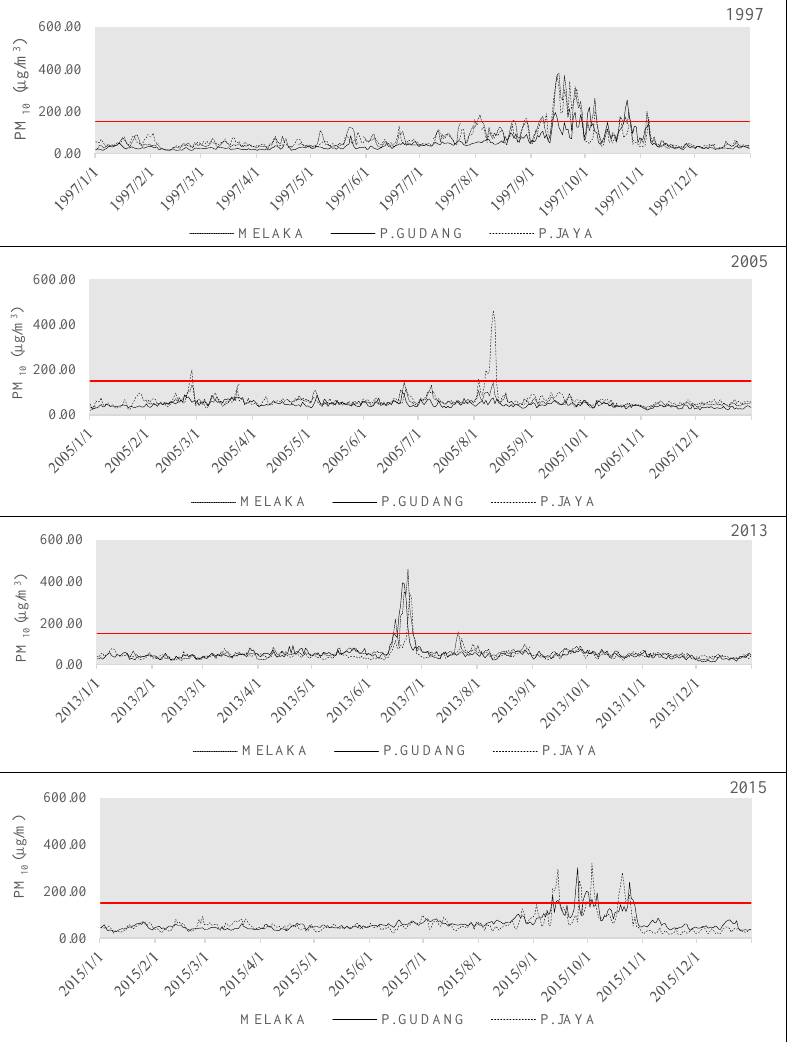
Figure 4. Daily time series plot of PM10 level in Petaling Jaya, Melaka, and Pasir Gudang in 1997, 2005, 2013, and 2015. Figure 5 shows the backward trajectories of air parcels during the haze events in 2005, 2013, and 2015 at the studied areas. The trajectories were calculated for 48 h periods at a height of 500 m above ground level (AGL). Figure 5a indicates that during haze event in August 2005, the air masses travelled from the North Sumatra region to Petaling Jaya;